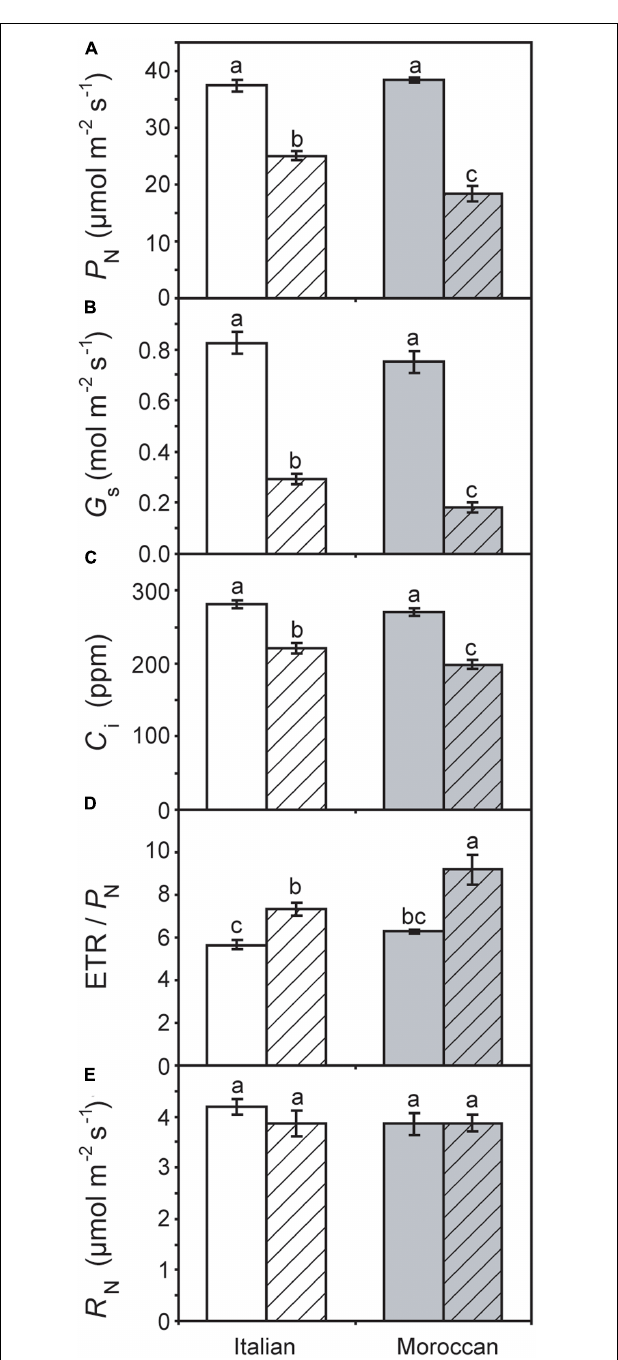
FIGURE 4 | Leaf gas exchange and simultaneous chlorophyll fluorescence parameters of Moroccan (gray) and Italian (white) A. donax ecotypes grown in the field under irrigated control (open) and rain-fed drought (hatched) conditions: (A) photosynthesis ( P N ); (B) stomatal conductance ( G s ); (C) internal sub-stomatal concentration of CO 2 ( C i ); (D) the ratio of electron transport rate (ETR) to P N , and; (E) respiration in the dark ( R N ). Error bars indicate one standard error either side of the mean ( n = 6). Letters indicate homogenous groups determined using a one-way ANOVA and LSD post hoc